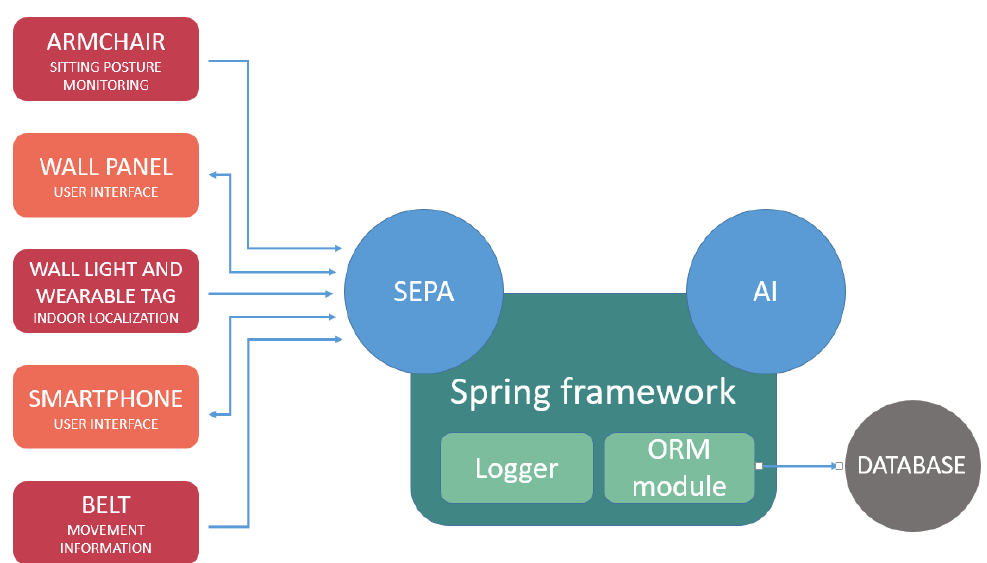
Figure 3. HABITAT (Home Assistance Based on the Internet of Things for the Autonomy of Everybody) ecosystem overview. The circles contain the different modules of the devices. The arrows depict communication between different devices and modules. SEPA: SPARQL Event Processing Architecture; SPARQL: Simple Protocol and RFD Query Language; RDF: Resource Description Framework; AI: Artificial Intelligence; ORM: Object Relational Mapping.